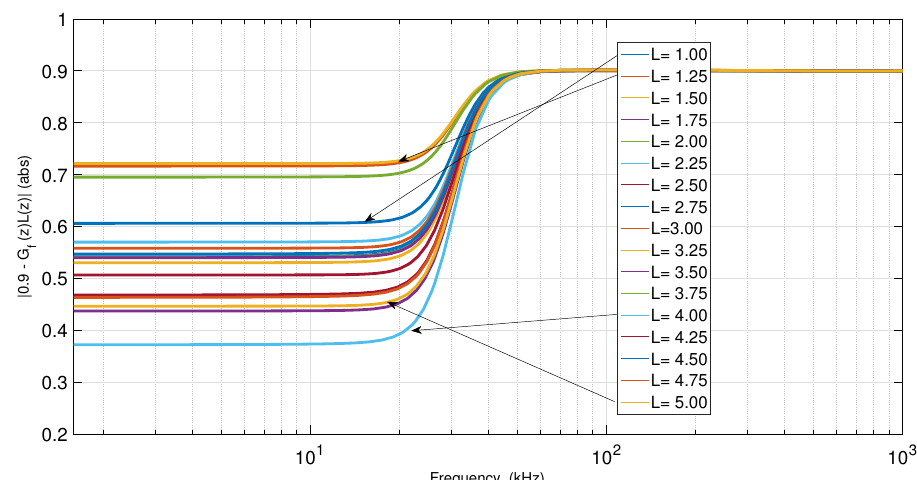
Figure 6. Effect of learning function L is studied on learning convergence. Bode magnitude plot of | 0.9 − G ( z ) L ( z ) | for L = 1:0.25:5. f